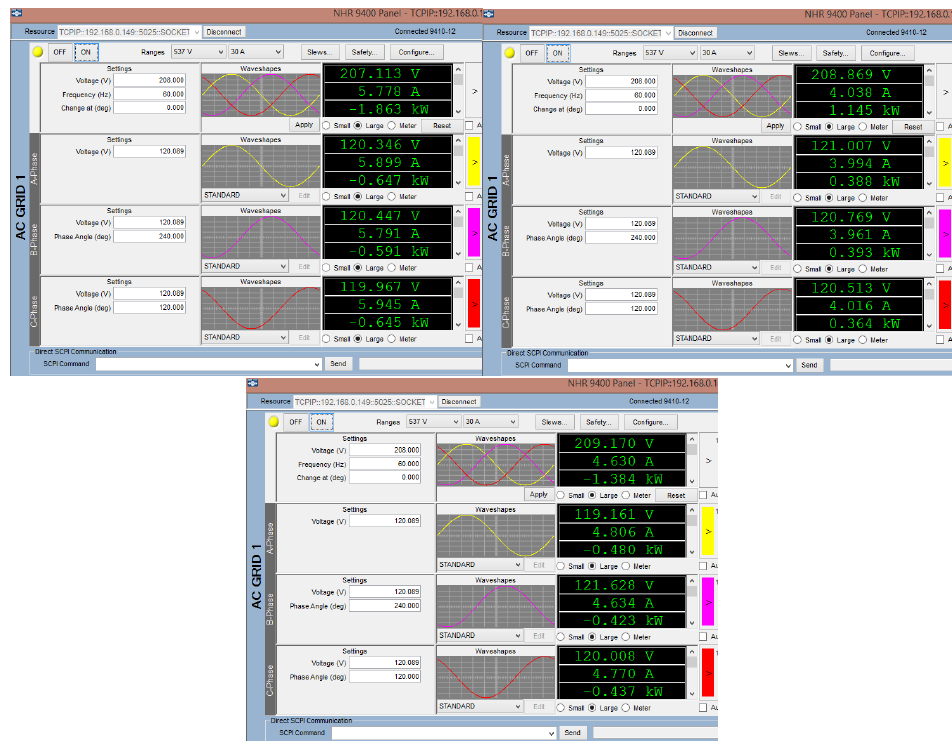
Figure 20. Experimental results using grid simulator NHR 9400